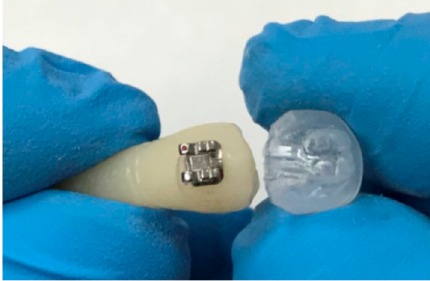
Figure 2. Transparent thermoplastic mould specially designed to standardize the placement and bonding of brackets.